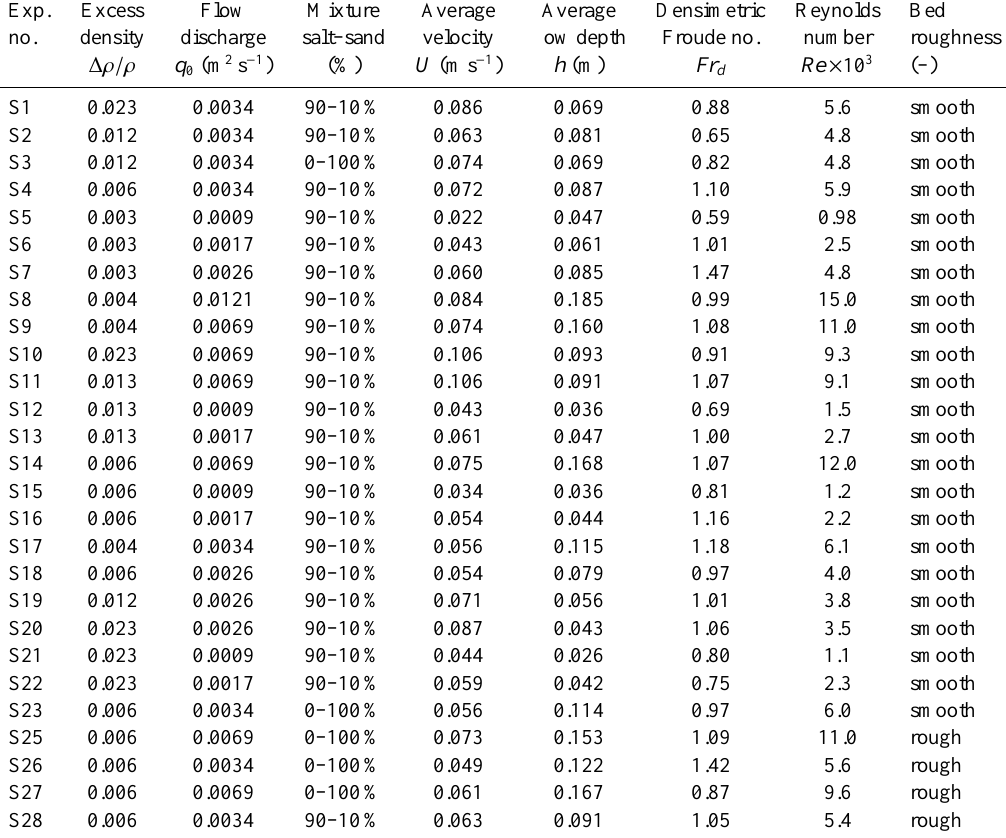
Table 1. Summary of the principal characteristics of the 27 experiments performed. Exp. Flow Mixture Average Average Densimetric Reynolds